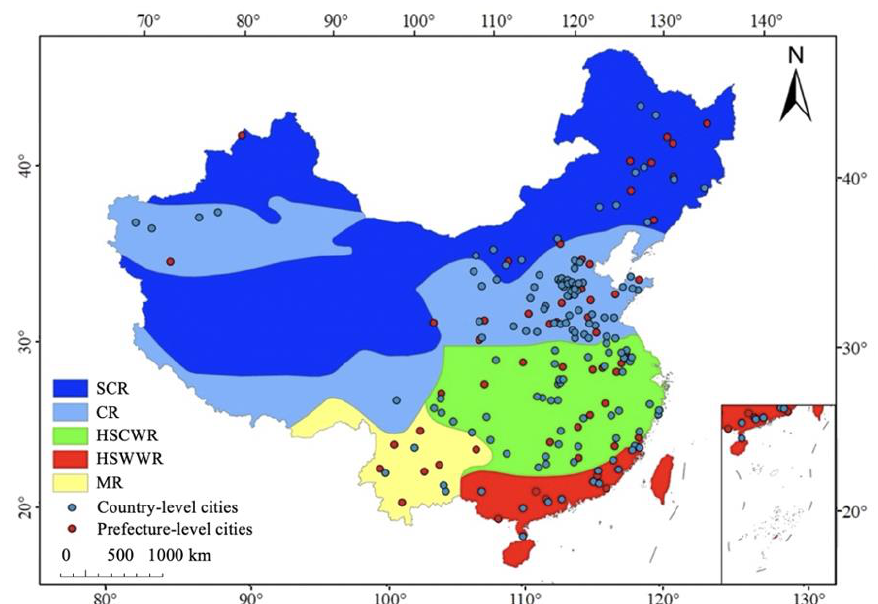
Figure 1. The locations of the selected 61 prefecture-level cities and 136 county-level cities in the five building climate zones (SCR, CR, HSCWR, HSWWR, and MR) in China.